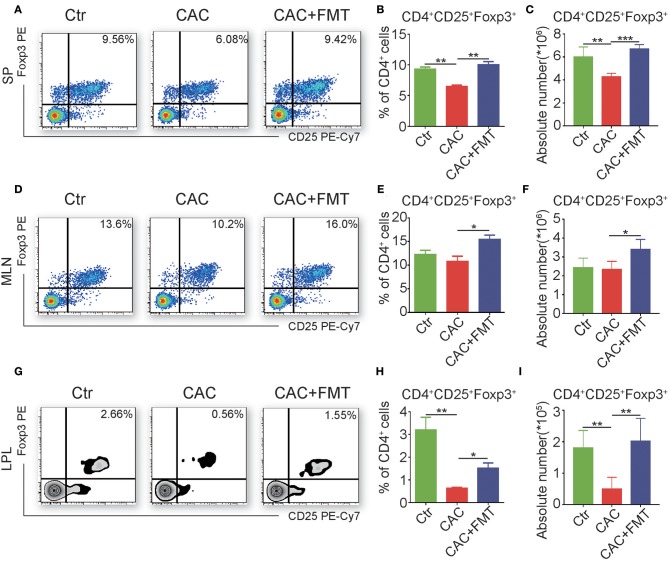
Fecal microbiota transplantation (FMT) promotes regulatory T (Treg) cell responses. (A–I) Single-cell suspensions of mouse lamina propria lymphocyte (LPL), mesenteric lymph node (MLN), and spleens from each group were prepared. Cells were stained with CD4-FITC, CD25-PE-Cy7, and then intracellularly stained with phycoerythrin (PE)-conjugated antibodies against Foxp3 for fluorescence-activated cell sorting (FACS) analysis of Treg cells. Representative FACS gates from spleen (A–C), MLN (D–F), and LPL (G–I) are presented. The proportion (B,C,H) and absolute numbers (C,F,I) of Treg cells in CD4+ T cells from splenocytes (A–C), MLN (D–F), and LPL (G–I) from each group were analyzed by FACS. Data are expressed as the mean ± SD of six mice for each group from one representative experiment. All experiments were repeated three times with similar results. *P < 0.05, **P < 0.01, ***P < 0.001 (ANOVA/LSD).